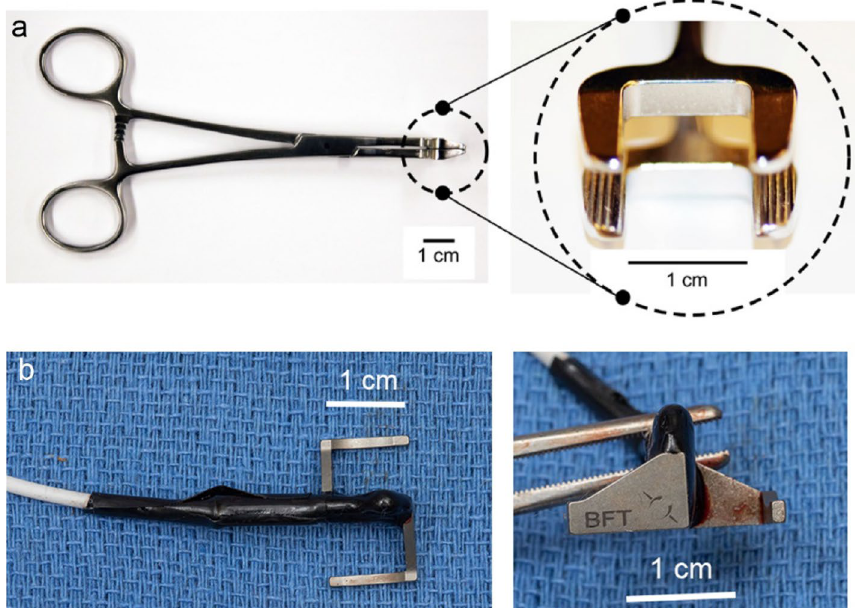
Figure 2. Biopsy clamp and BFT. ( a ) Side view of modified biopsy clamp and close up view of clamp jaws. ( b ) Top and side view of